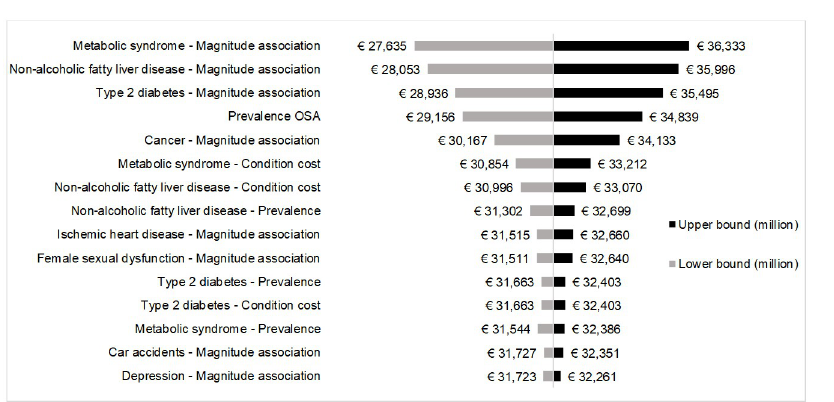
Fig 2. Tornado plot for sensitivity analysis (model 1).